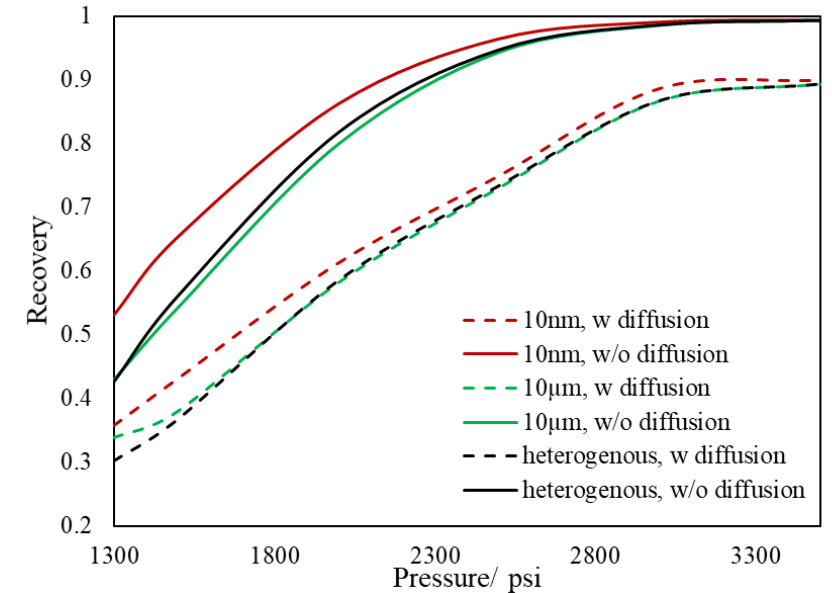
Figure 17. C 5 -C 6 Composition recovery as a function of pressure with and without diffusion for slim tube simulation, Bakken, 1 µd.